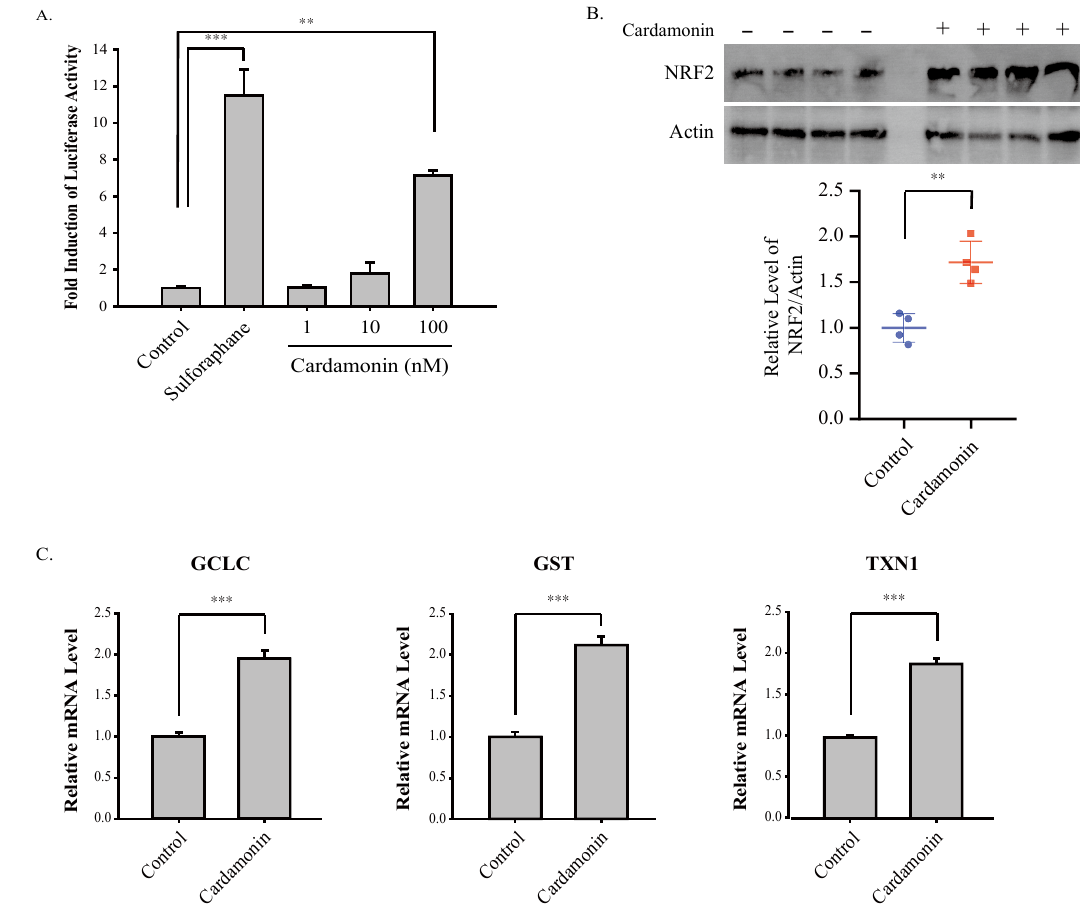
Figure 5. Cardamonin activates ARE-luciferase activity in HaCaT cells and induces the expression NRF2 and its target genes in mice. ( A ) Cardamonin induces ARE activation in HaCaT-ARE-GFP-luciferase cells. HaCaT-ARE-GFP-luciferase cells were exposed to cardamonin at various concentrations for 24 h and the luciferase activity was measured. The experiment was performed in triplicate and sulforaphane (10 μ M) was included as a positive control. Asterisks indicate a statistical significance of ** p < 0.01 and *** p < 0.001. ( B ) Cardamonin induces NRF2 in vivo. Cardamonin (100 nmole/mouse) was topically applied to the ear of mouse for 24 h and Western blotting was performed against NRF2 and actin (Upper Panel). The relative level of NRF2 was normalized against actin (Lower Panel). Asterisks indicate a statistical significance of ** p < 0.01. ( C ) Cardamonin induces NRF2 target genes in vivo. Cardamonin (100 nmole/mouse) was topically applied to the ear of mouse for 24 h and real-time RT-PCR was performed against NRF2 target genes (GCLC, GST, TXN1). The experiment was performed in quadruplicate. Asterisks indicate a statistical significance of *** p < 0.001.